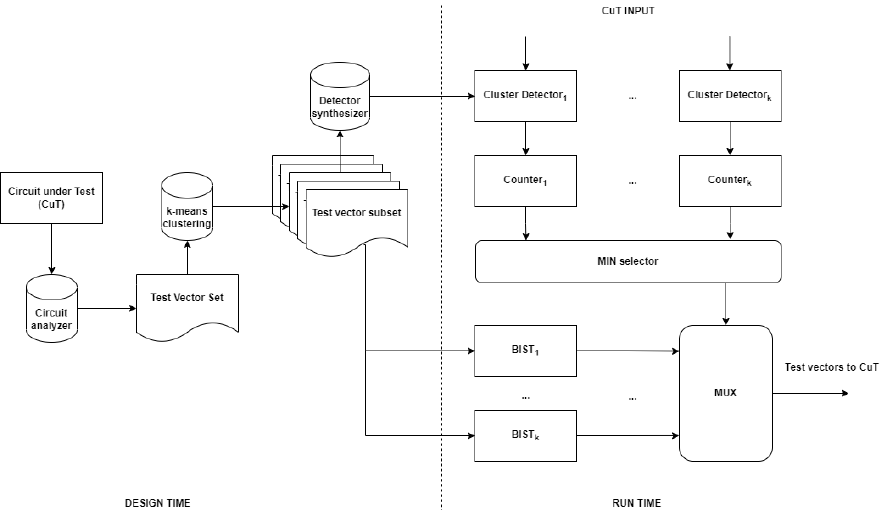
Figure 9. Methodology for designing the adaptive BIST and dynamic application of the appropriate test vector